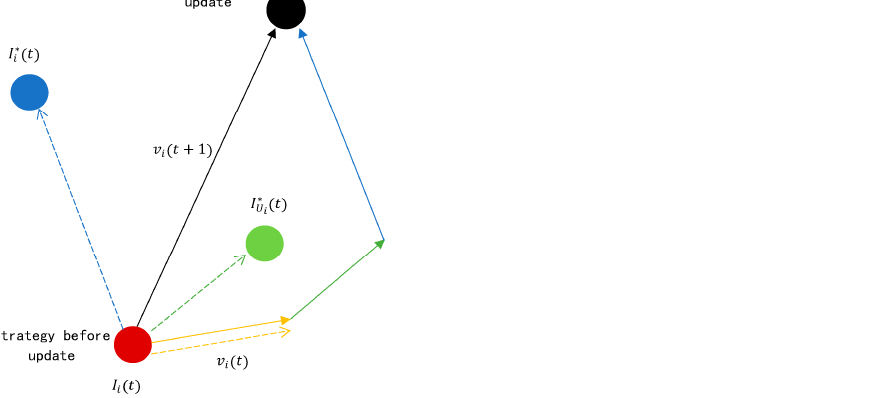
Figure 2. Schematic diagram of the PSO algorithm guiding the strategy adjustment. The algorithm pseudo-code and flowchart regarding the above model are given by Algorithm 1 and Figure 3, respectively.